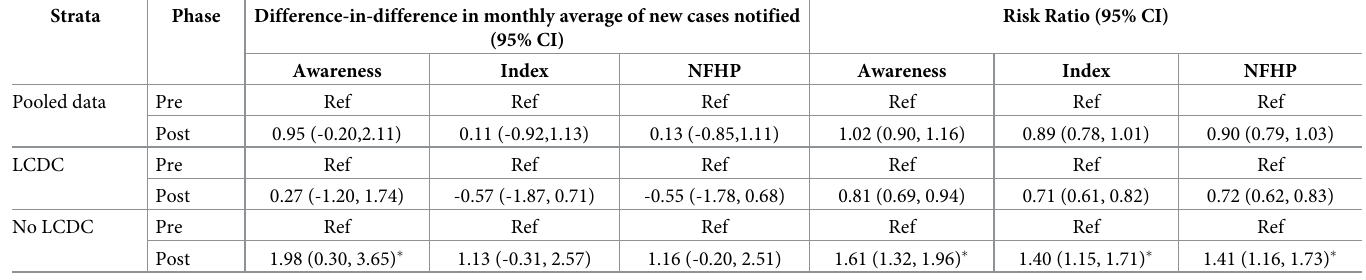
Table 3. Difference-in-difference in monthly average of new cases notified during intervention period as compared to pre intervention period across intervention blocks after adjusting for control blocks and its ratio.